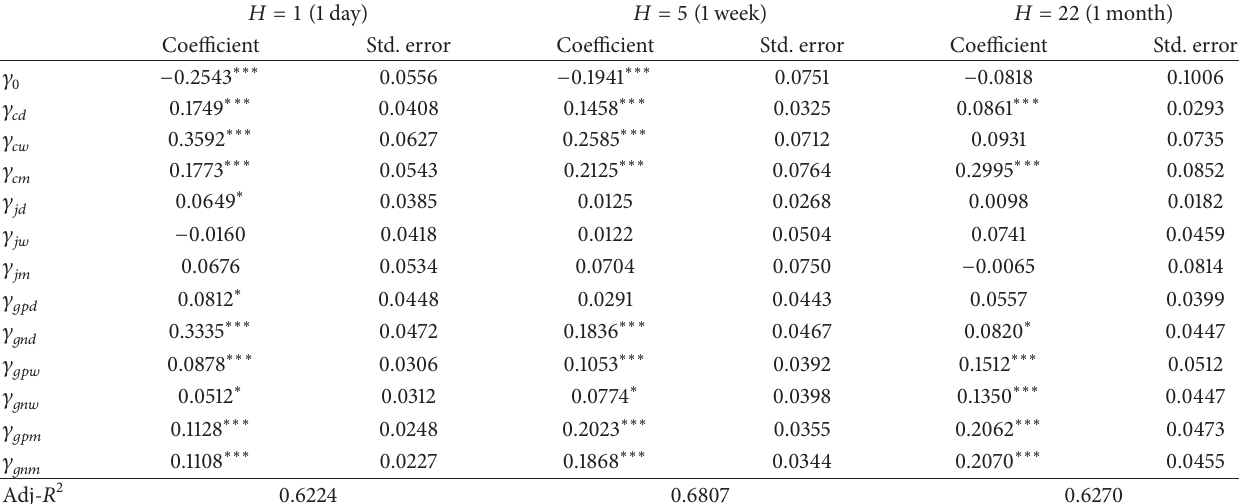
Table 2: Results of parameter estimation for HAR-CJ-M